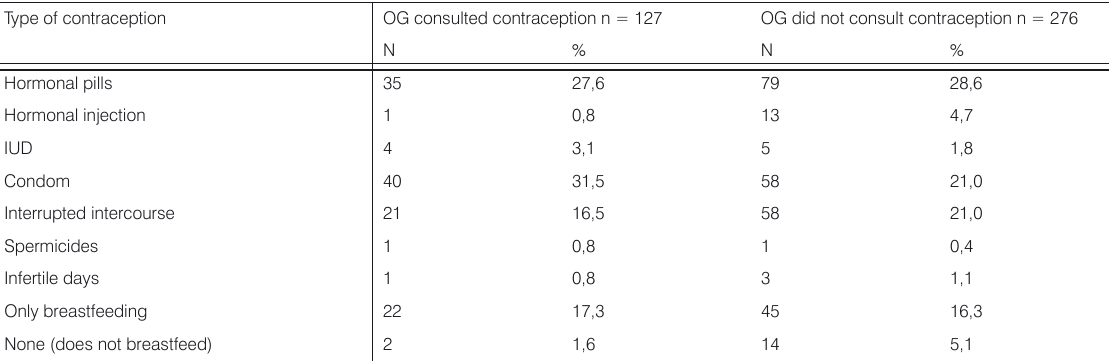
Table 4. Frequency of particular types of contraception dependent upon consultation with outpatient